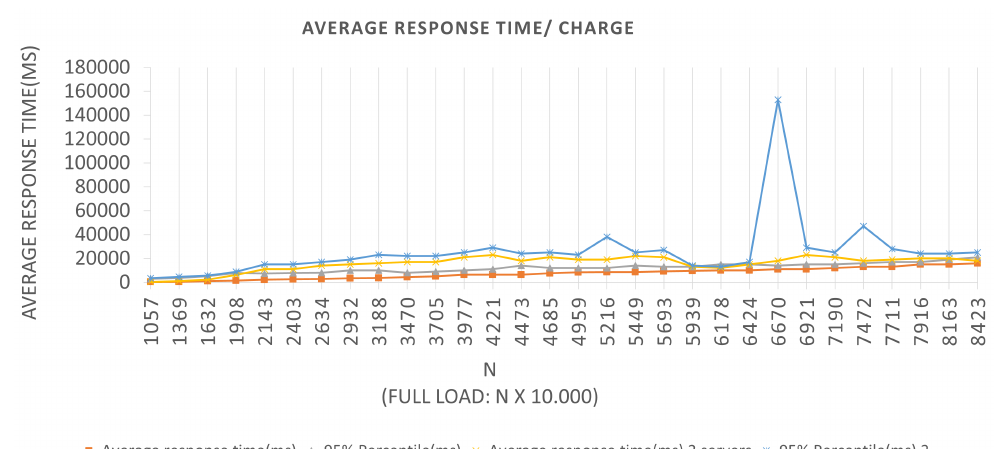
Figure 11. Results of the experiments for query loads.